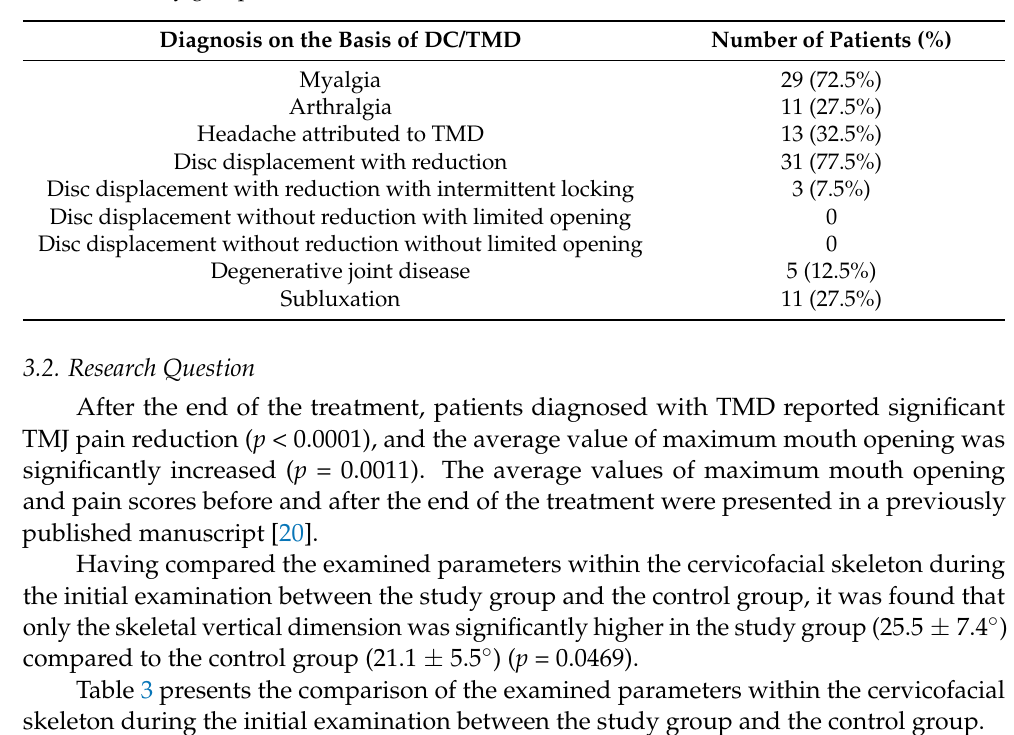
Figure 3. Flow of the participants during the study. TMJ—temporomandibular joint; TMD—temporomandibular joint disorders. TMD—temporomandibular joint disorders.